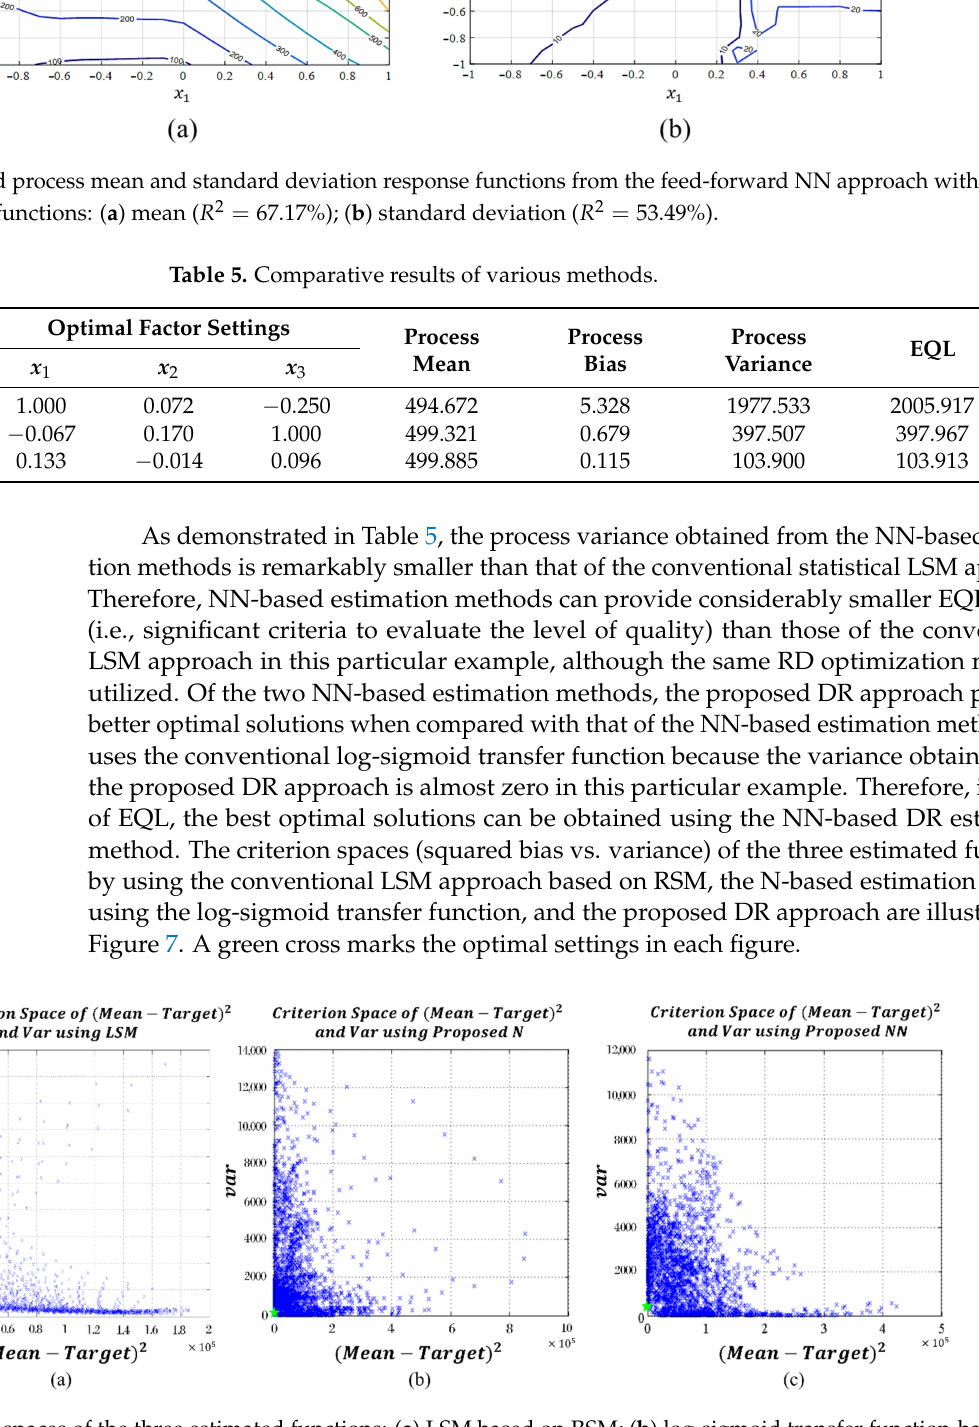
Figure 7. Criterion spaces of the three estimated functions: ( a ) LSM based on RSM; ( b ) log-sigmoid transfer function-based NN; ( c ) proposed NN-based DR